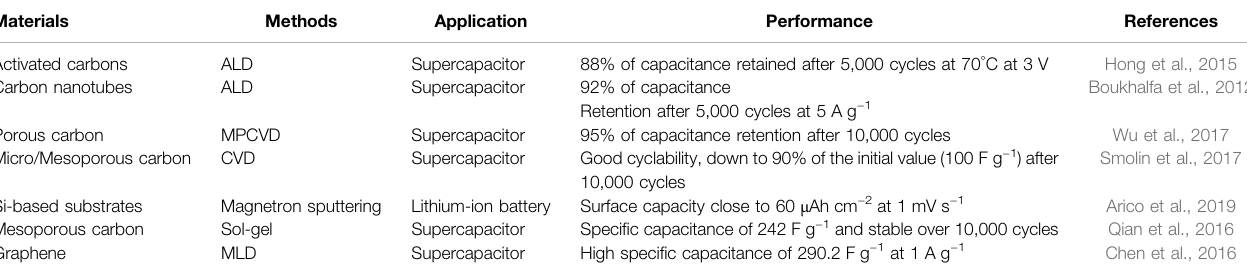
TABLE 1 | The performance comparison between different fi lm coating methods on carbons.